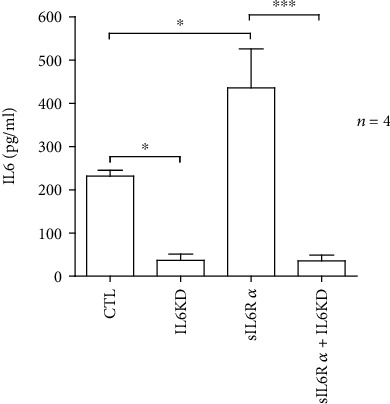
siRNA-mediated knockdown of interleukin 6 (IL6) in human vascular endothelial cells (HUVECs). Knockdown was performed in the presence and absence of the soluble IL6 receptor (sIL6Rα) (100 ng/ml). The release of IL6 into the cell culture medium was measured using ELISA 48 h after siRNA was introduced. Data from four independent experiments performed in duplicate are shown. ∗p < 0.05 and ∗∗∗p < 0.001.